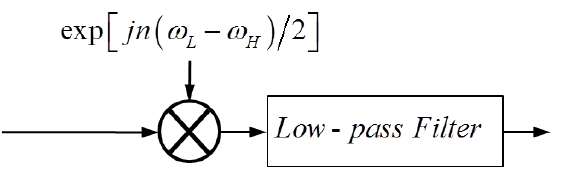
Figure 4. Block diagram of the analysis filter.